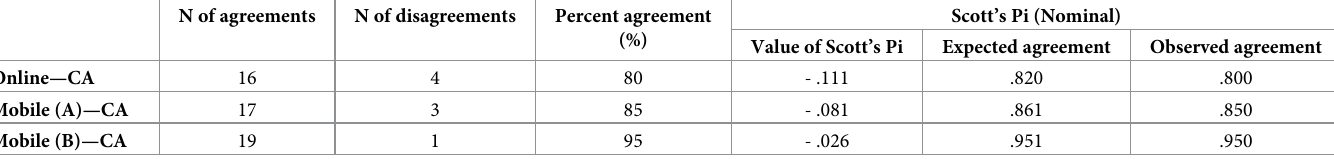
Table 2. Inter-rater reliability between the self-rated K-CESD-R scales and a clinician-administered diagnostic